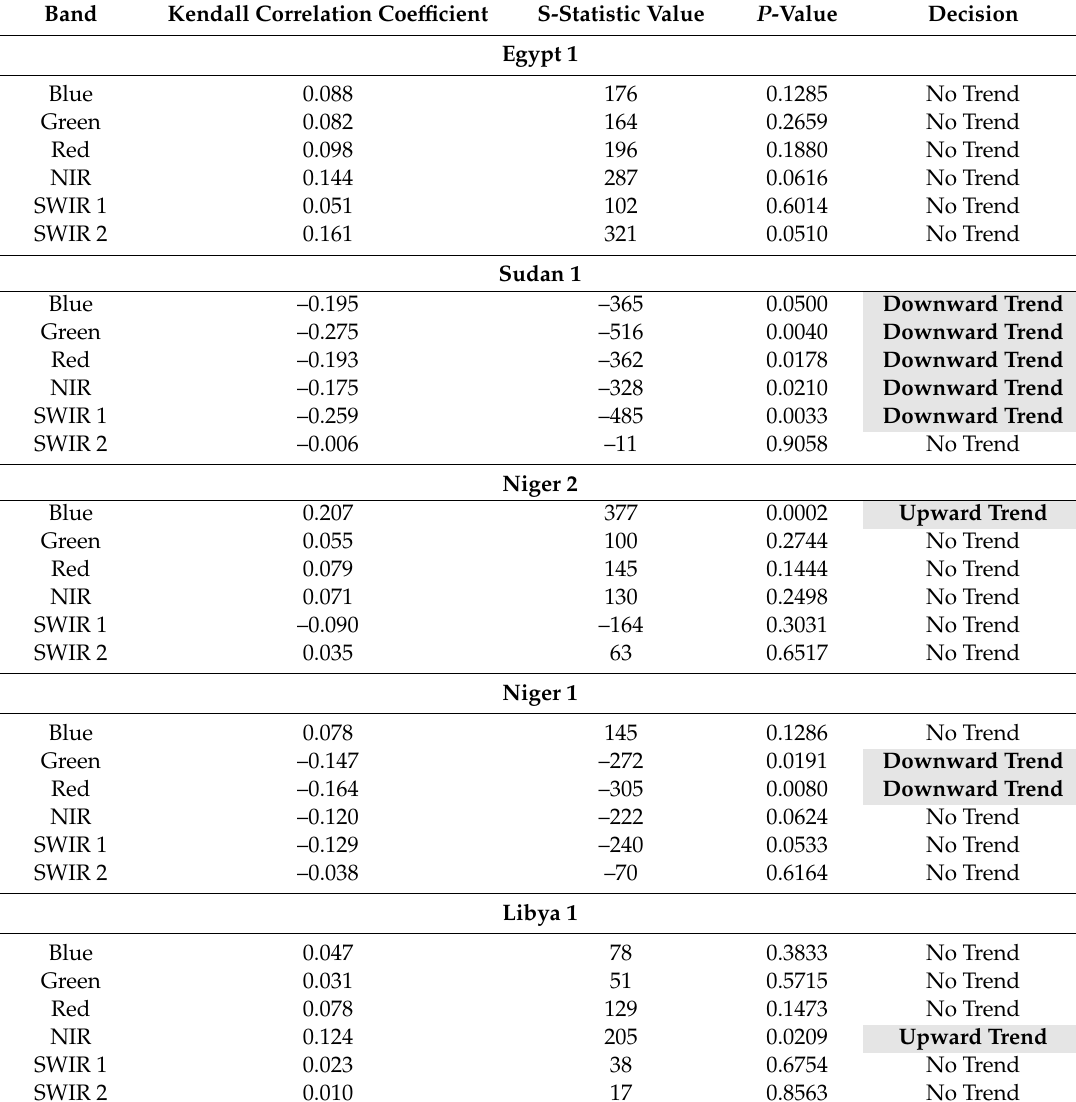
Table 12. Seasonal Mann-Kendall test results for Combined Sensor TOA Reflectance Datasets at Remaining SDSU Sites, α =